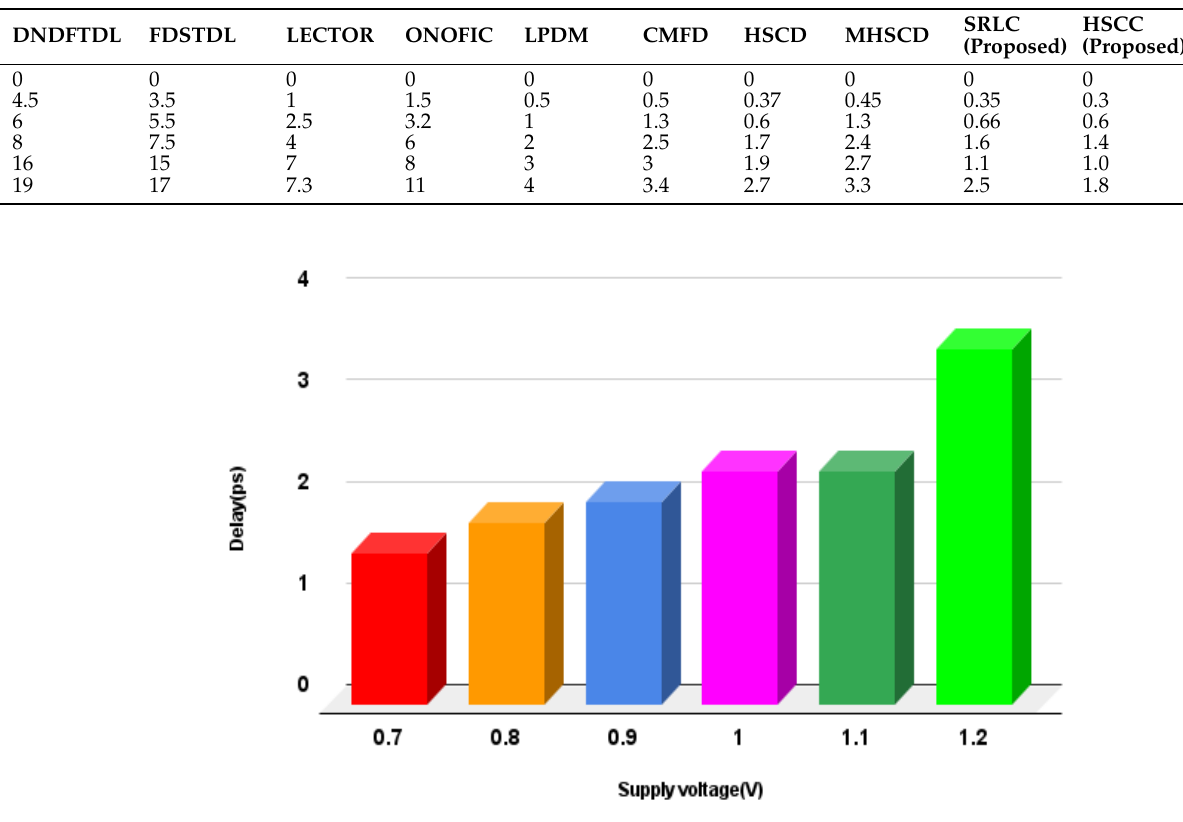
Figure 21. Simulation of delay with the variation of supply voltage at V t =0.02 V of FinFET-based SRLC circuit at 7 nm.